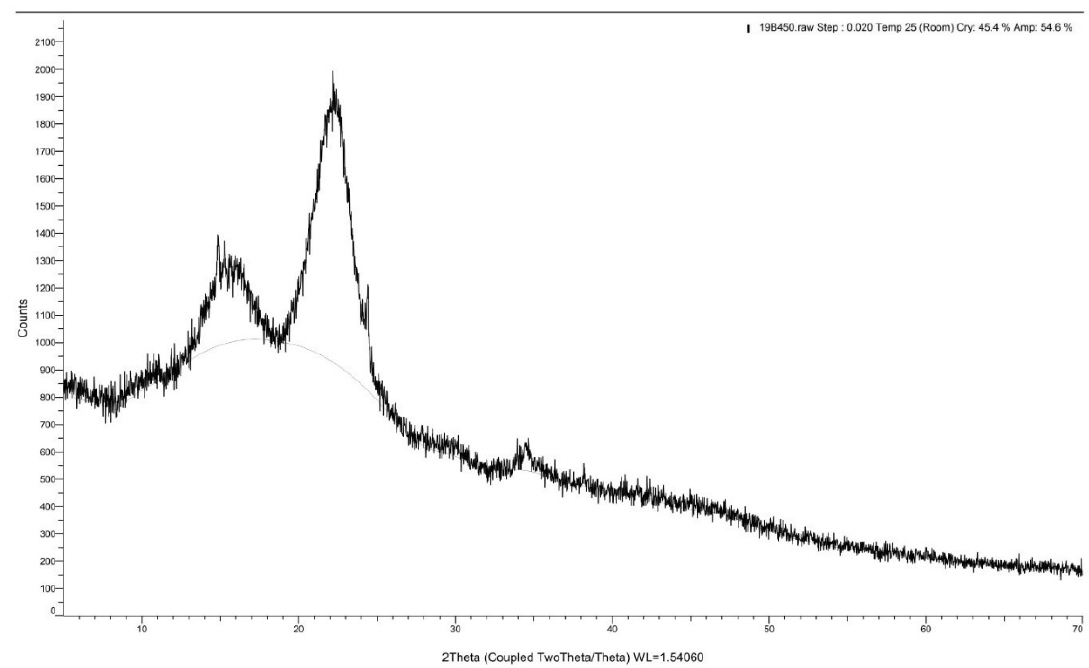
Figure 4. X-ray diffraction spectrum for Rhizophora spp. particleboard bonded with 0% binder.